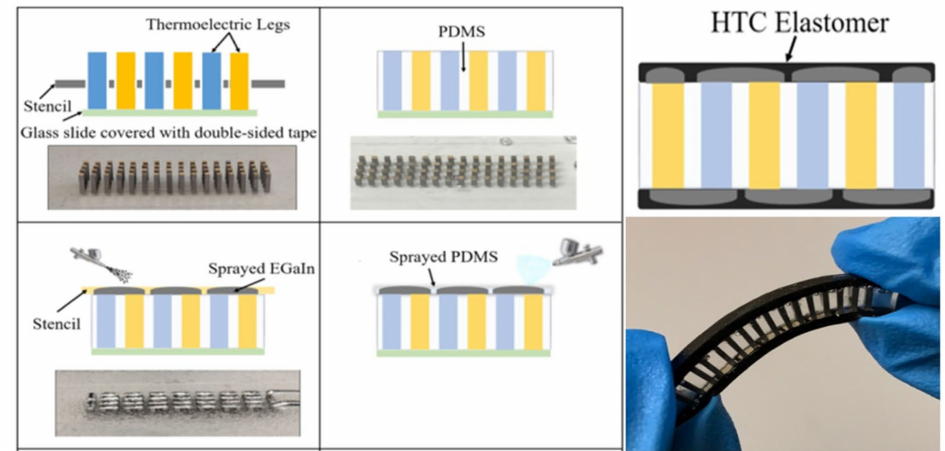
Figure 9. Schematic of the FTEG with flexible high thermal-conductivity substrates based on EGaIn/PDMS [62].